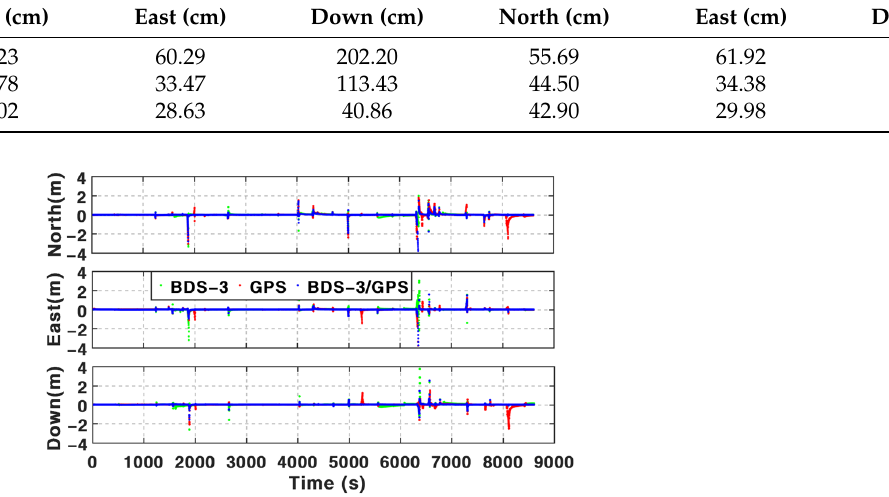
Figure 12. Positioning differences between BSSD PPP/INS TCI and BSSD PPP/INS/ODO TCI with different GNSS.